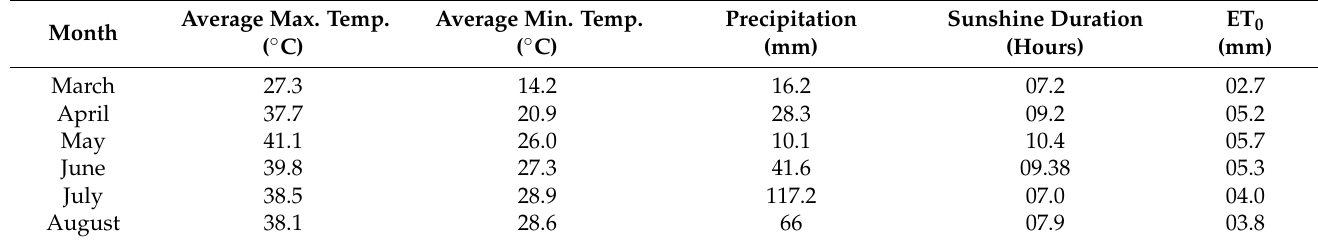
Table 2. Climatic conditions data during experimental